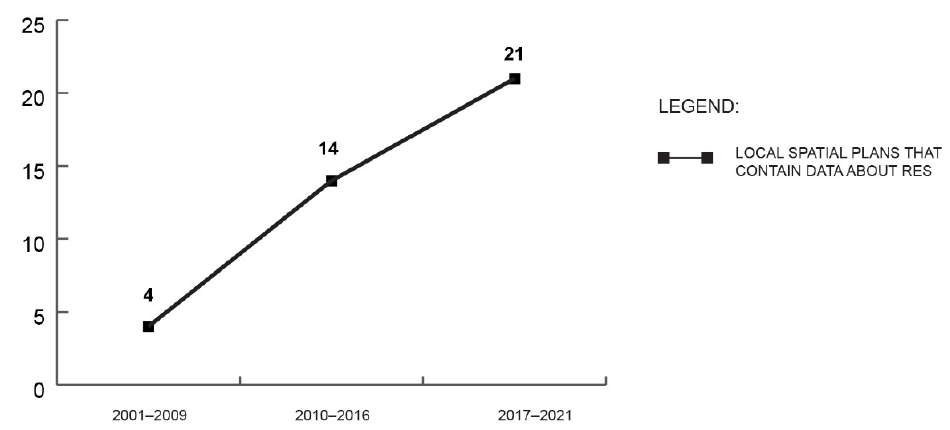
Figure 7. The number of plans containing RES data over time bands. Source: own study.